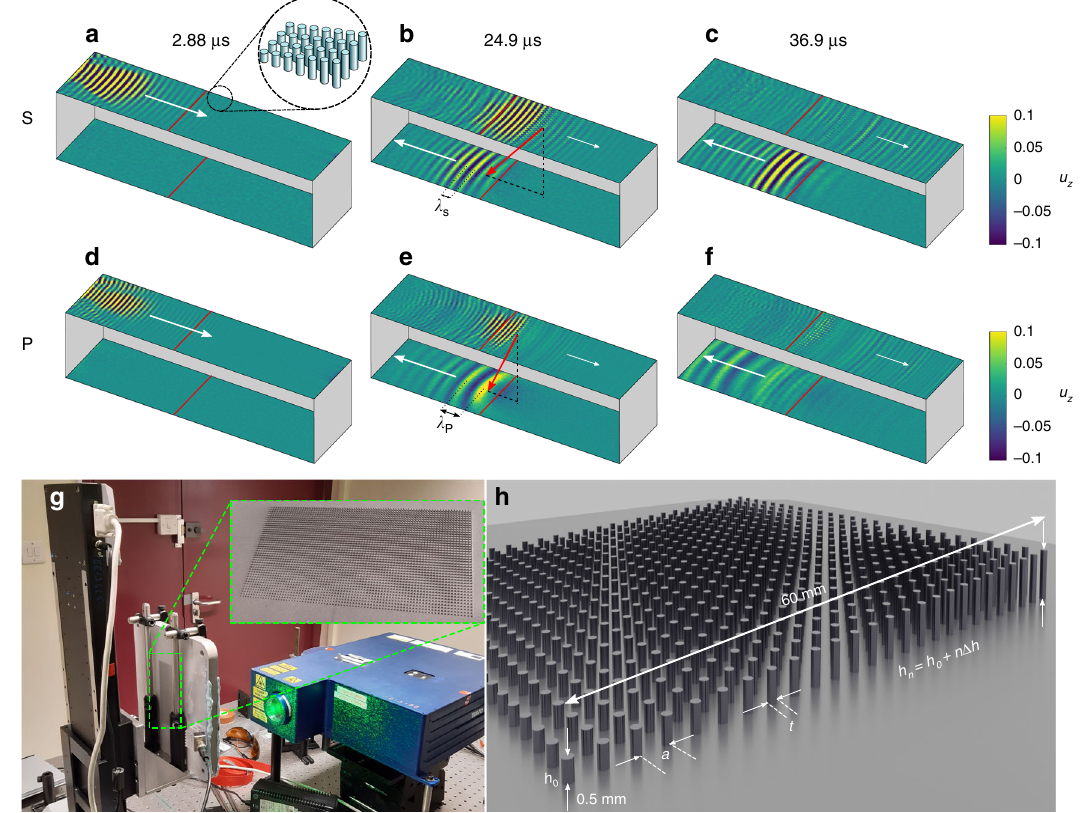
Fig. 1 Experimental results. Snapshots in time of temporal – spatially fi ltered scans along top and bottom surfaces observing S conversion ( a – c ) and P conversion ( d – f ), fi ltered between 1.1 – 1.2 and 1.45 – 1.55 MHz, respectively, normalised to the maximum of displacement of the top surface ( u z ). Solid red lines show where graded array begins, with increasing rod height in the direction of wave propagation on the top surface. The reversed conversion is clear; the forward propagating surface wave on the top surface is reverse converted into the bulk and is seen to excite reversed propagating surface waves on the bottom surface. The measured angles of reversed conversion, − 131.8 ∘ and − 106.9 ∘ for S and P, respectively, match the predicted angles from Fig. 3, with the separate polarisations evident from the difference in excitation wavelength on the bottom surface, marked λ S , λ P . The experimental setup is shown g , as is a schematic of array geometry h detailing the rod diameter, t , periodicity a and grading through the changes in height of the n th rod, h n , as h n = h 0 + n Δ h . Fabrication details are given in the “ Methods ” section, with the array parameters given in Supplementary Table